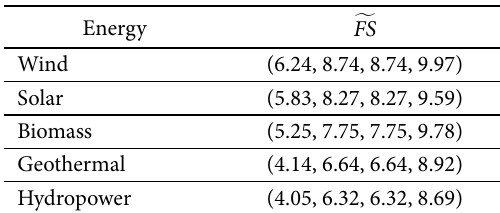
Table 3. Fuzzy scores of renewable energy